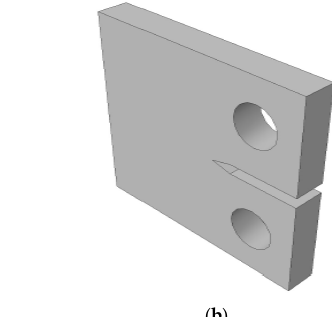
Figure 6. Boundary conditions and loads in the models.